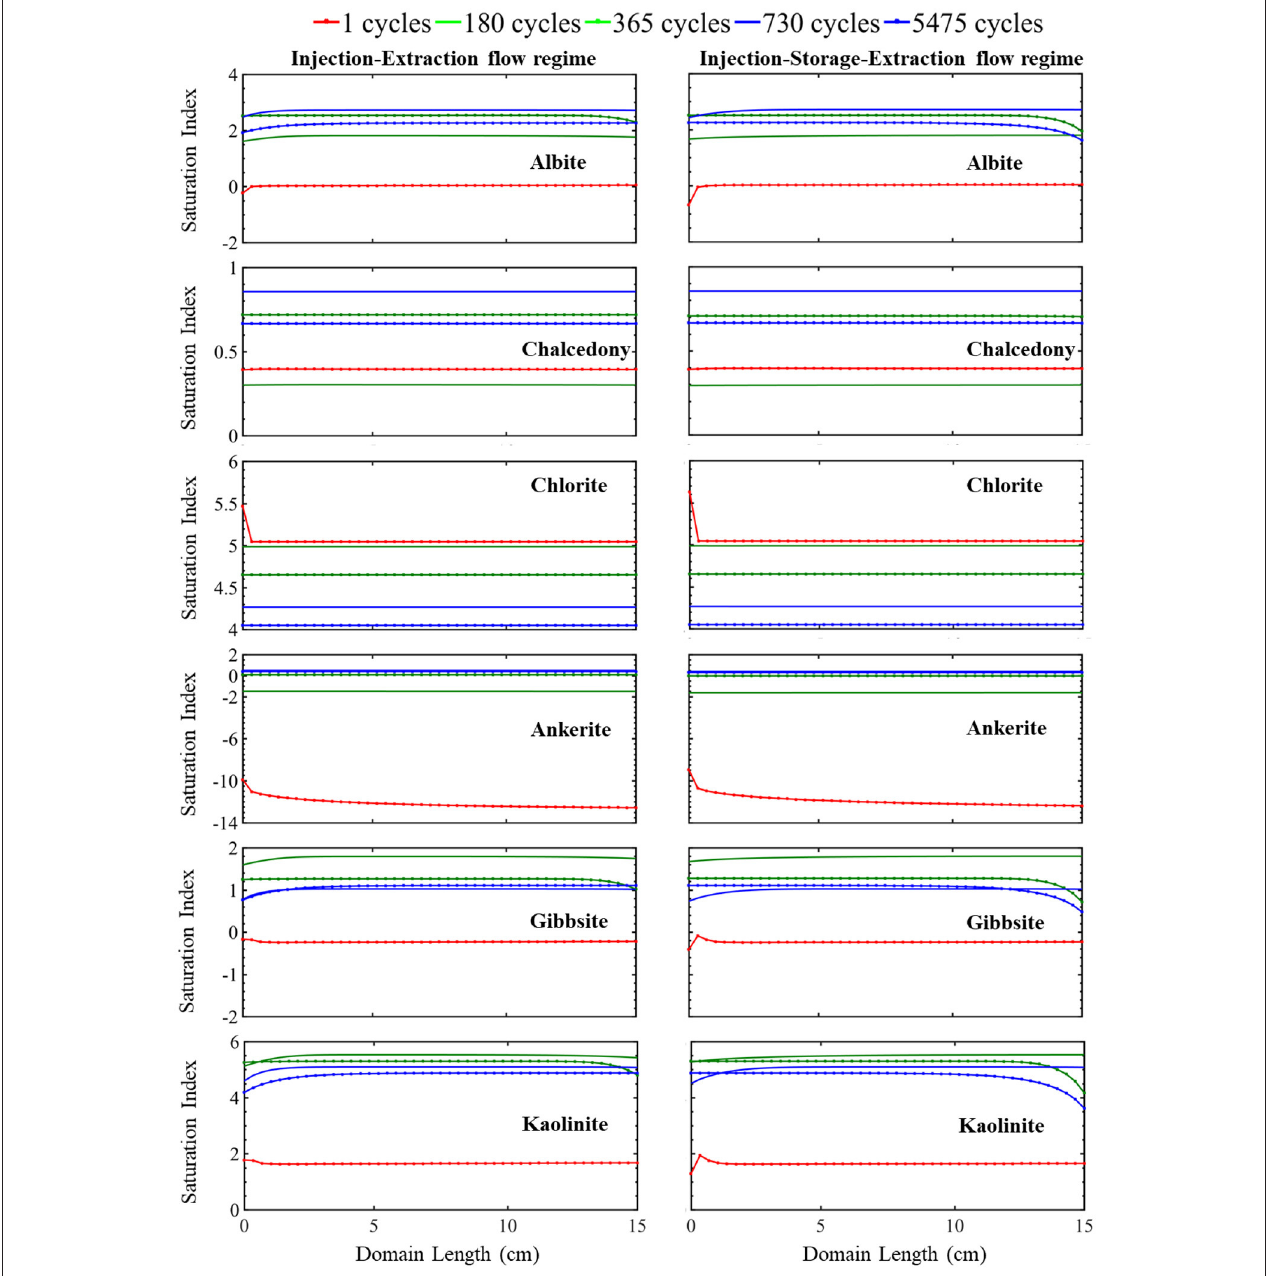
FIGURE 3 | The simulated evolution of mineral saturation index across the simulation domain at certain times over 15 years for the injection-extraction flow regimes (left) and injection–storage–extraction flow regimes (right). A positive saturation index indicates precipitation potential and negative precipitation index indicates dissolution potential. The dotted red line is 1 day, green 0.5 years, dotted green 1 year, blue 2 years, and dotted blue 15